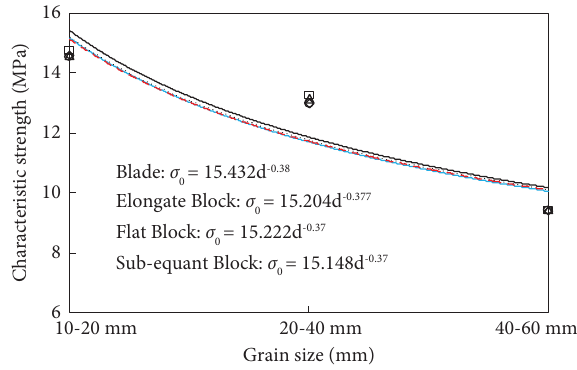
Figure 12: Relationship between the characteristic stress and particle size function of four types of particle shapes. Table 6: Power function parameters within four diferent shapes. Value Shape Value m by − 3/ m by ftting Equation (3) Blade particles − 0.38 − 1.30 Elongated particles − 0.38 − 1.21 Flat particles − 0.37 − 1.14 Subspherical particles − 0.37 −